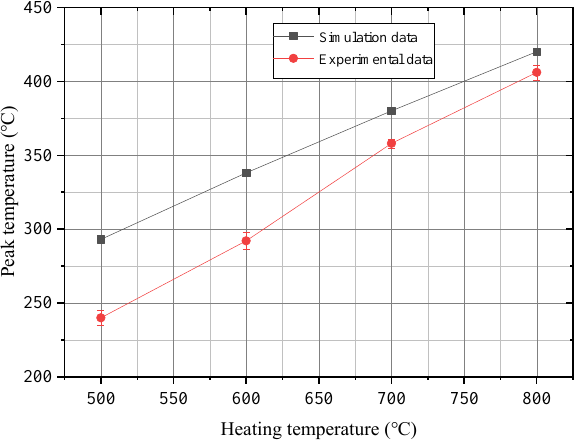
Figure 13. Comparison of the peak temperature of the first layer under different heating temperatures.